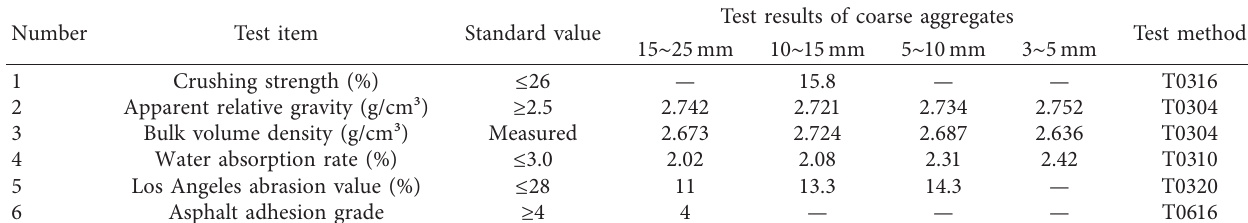
Table 2: Physical and mechanical indices of coarse aggregates with different particle sizes.